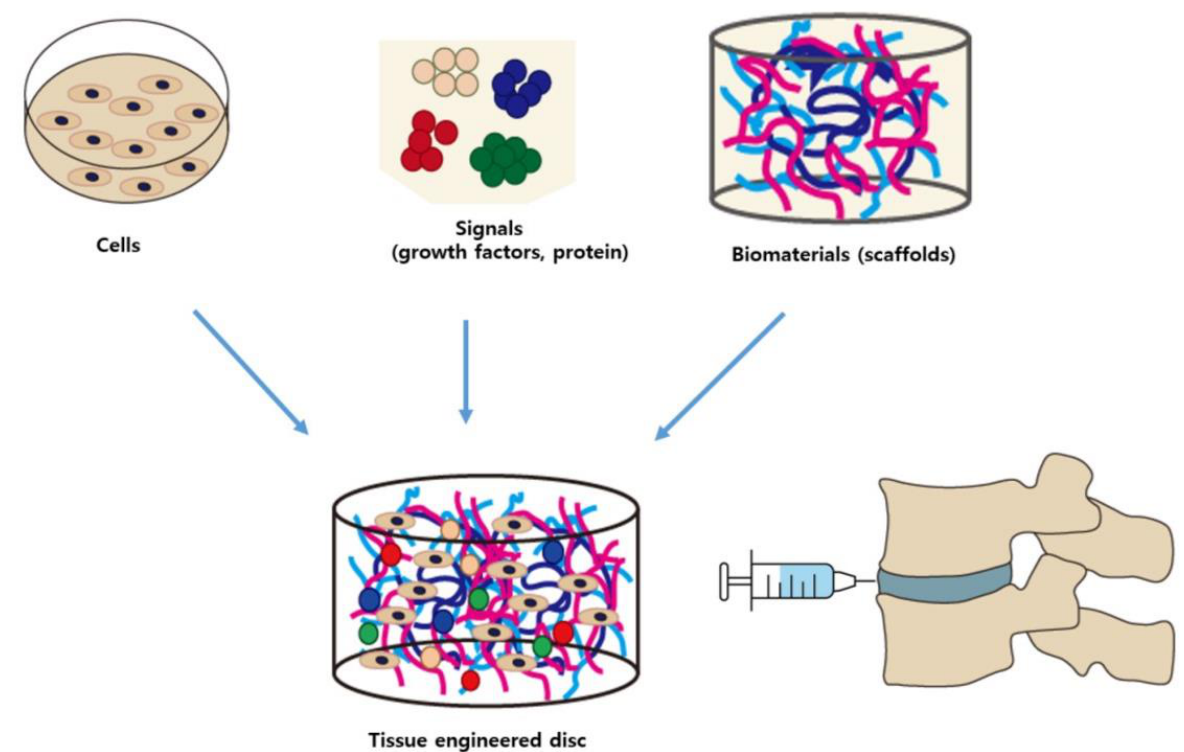
Figure 2. Combination of cells, signaling molecules (growth factors), and biomaterials for tissue engineering applications for intervertebral disc (IVD) degeneration.